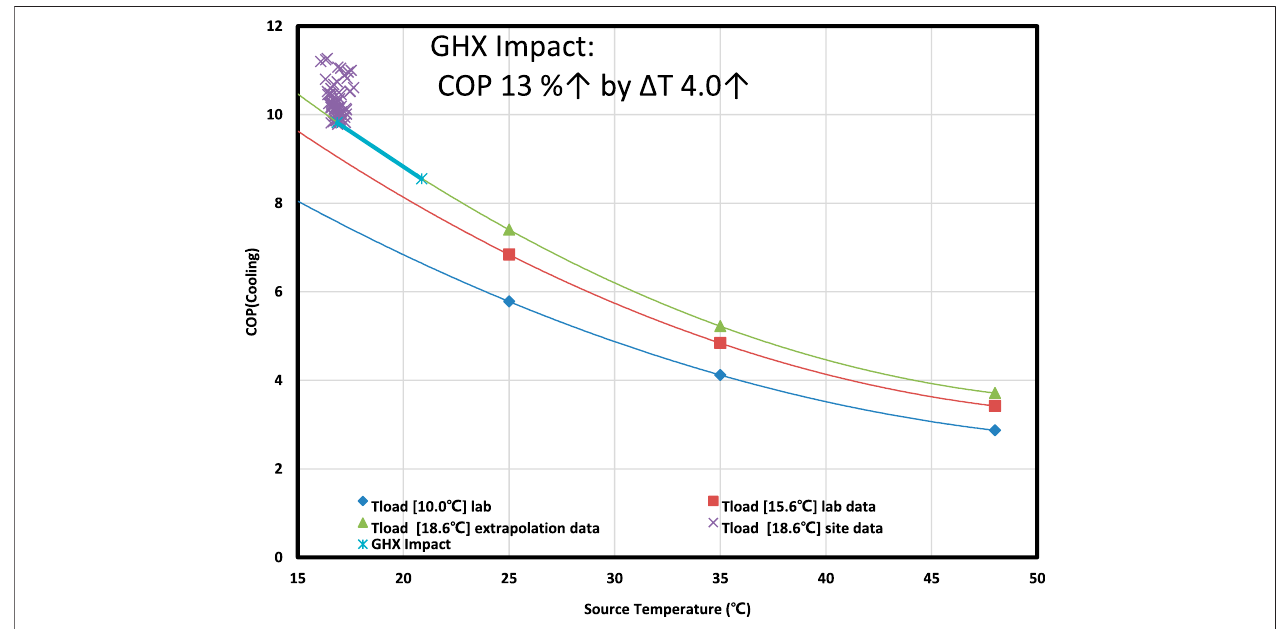
FIGURE 5 | WWHP lab vs. demonstration cooling heat pump performance (COPc) comparison.